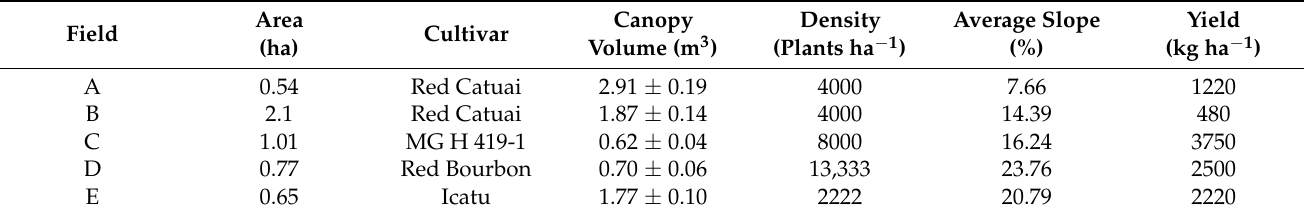
Table 4. Characteristics of the five arabica coffee fields used in this